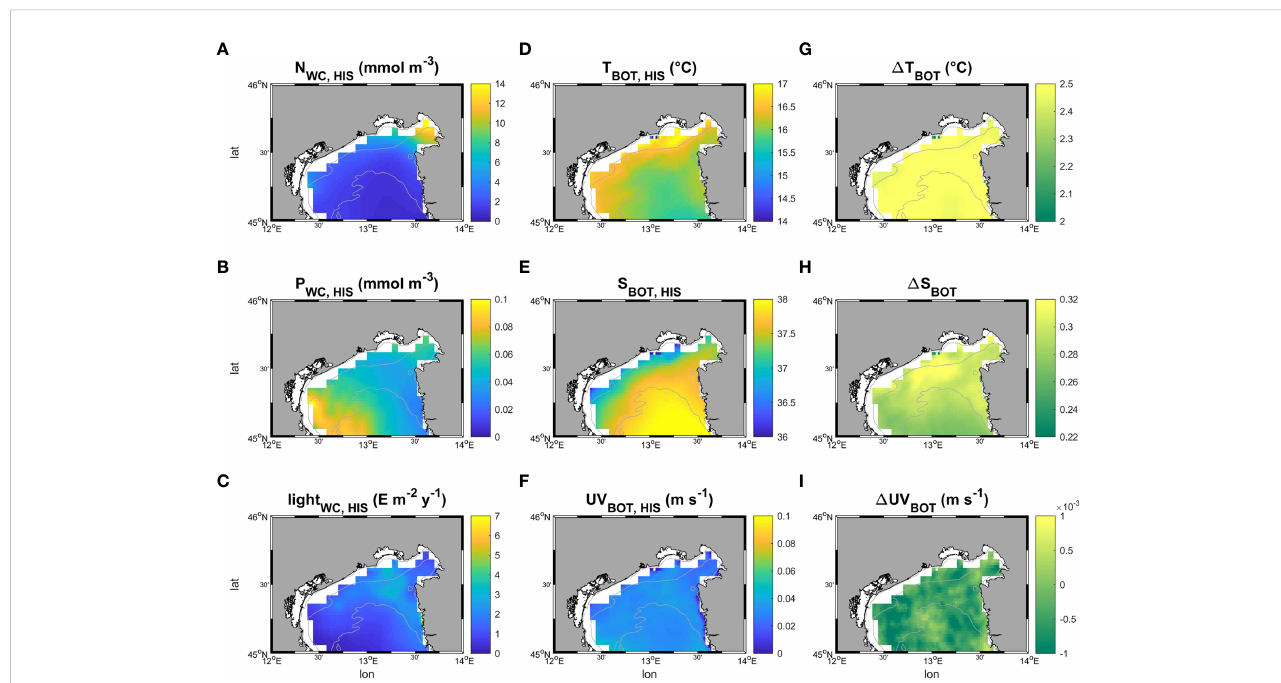
FIGURE 4 Patterns of the six environmental variables employed in this study. (A – F) show respectively the time averaged patterns of nitrate and phosphate concentration along the water column, and light, temperature, salinity and velocity at the sea bottom in the historical period (1999-2018). (G – I) map the difference ( D ) in bottom temperature, salinity and current velocity speed between future (under a severe climate change scenario RCP 8.5, 2070-2099 – SCE) and historical conditions